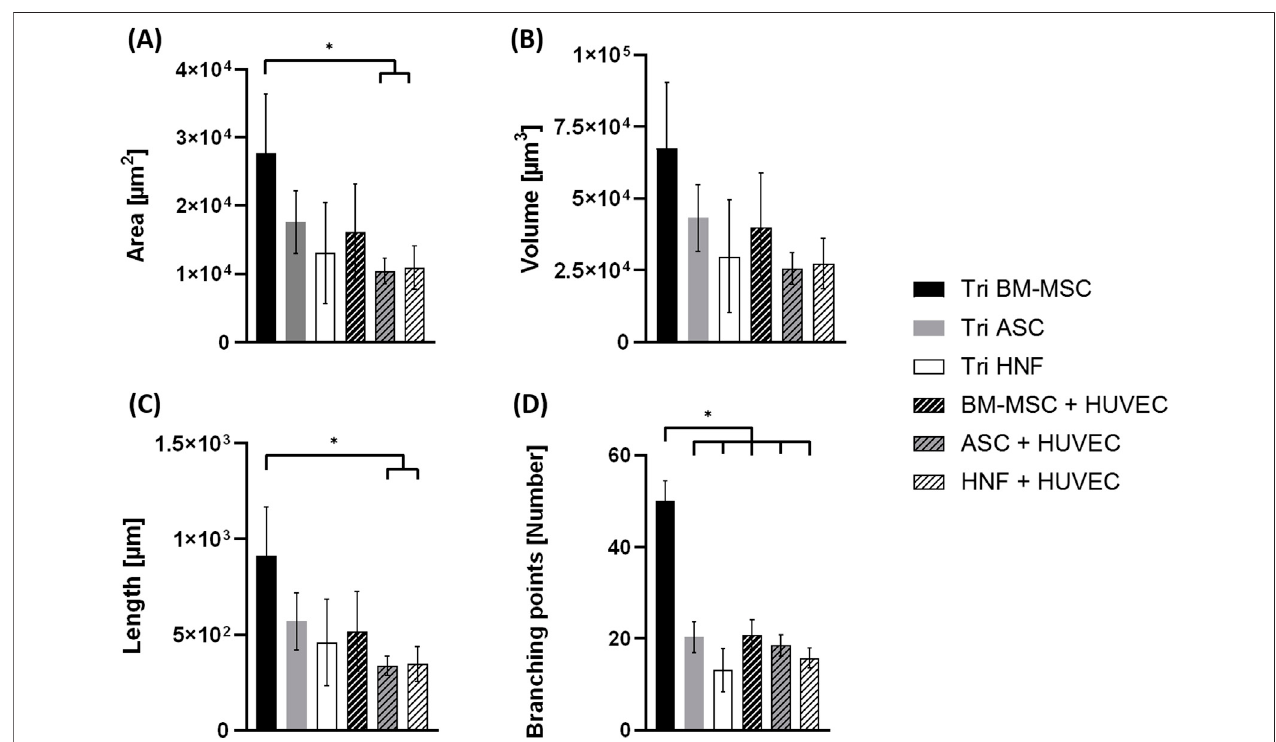
FIGURE 7 | Statistical evaluation of vascularization in co-cultures with HUVEC and tri-cultures. (A) . area of vascular-like structures (B) . structure volume (C) . structure length (D) . number of branching points. Statistical signi fi cance ( p < 0.05) is indicated by “ * ” .